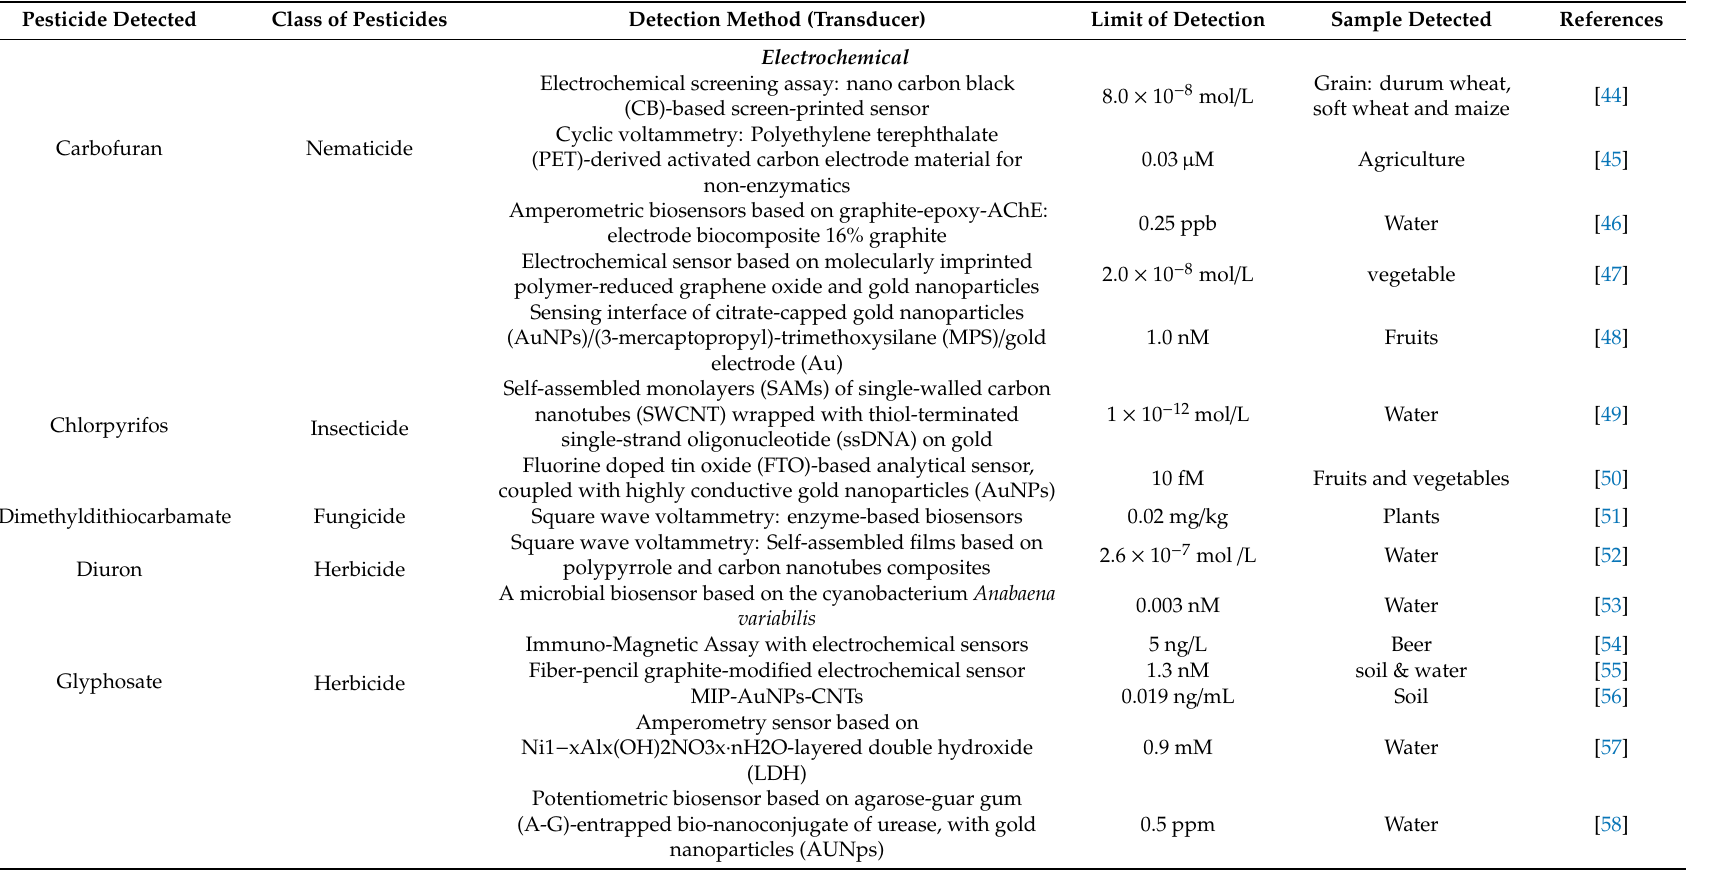
Table 3. Sensors developed for pesticides using various